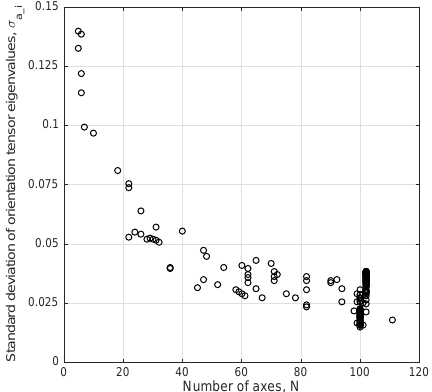
p a i , of the eigenval-